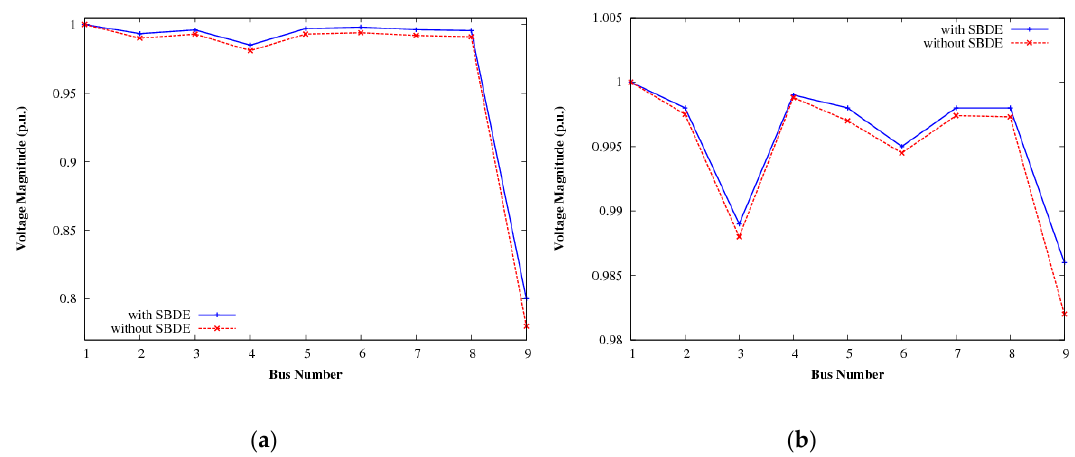
Figure 7. The comparison graph of voltage magnitude at different buses with and without using the Table 3. Reactive power production cost of generator.